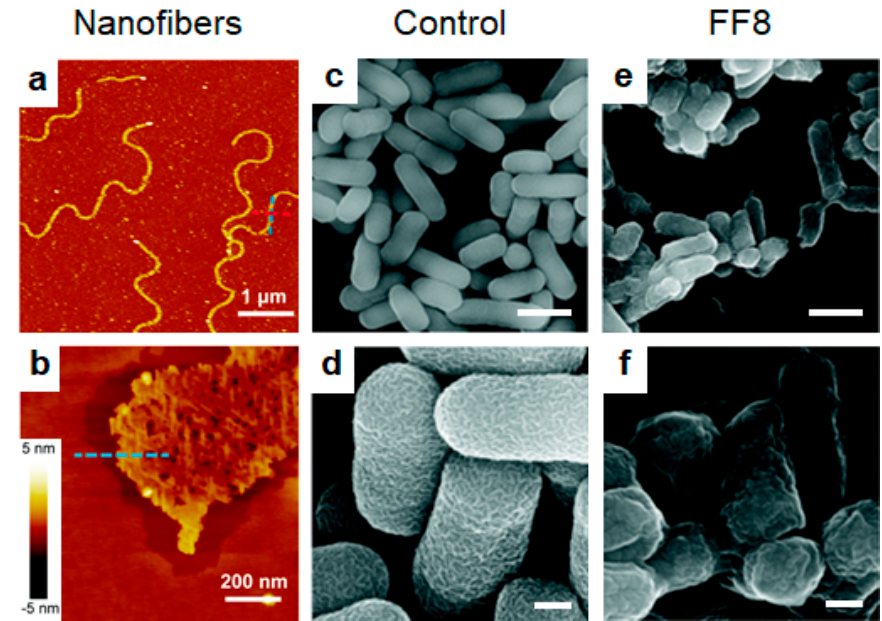
Figure 2. FF8 self-assembly into nanofibers and antimicrobial activity. ( a ) AFM nanofiber assembly with ( b ) zoomed in profile of the edge both observations in a basic environment. ( c ) SEM of untreated E. coli with ( d ) zoomed in morphology micrographs. ( e ) SEM of E. coli treated with FF8 with ( f ) zoomed in morphology micrographs. Scale bars a, c, e = 1 µ m and b, d, f = 200 nm. Adapted from [73] with permission from The Royal Society of Chemistry.